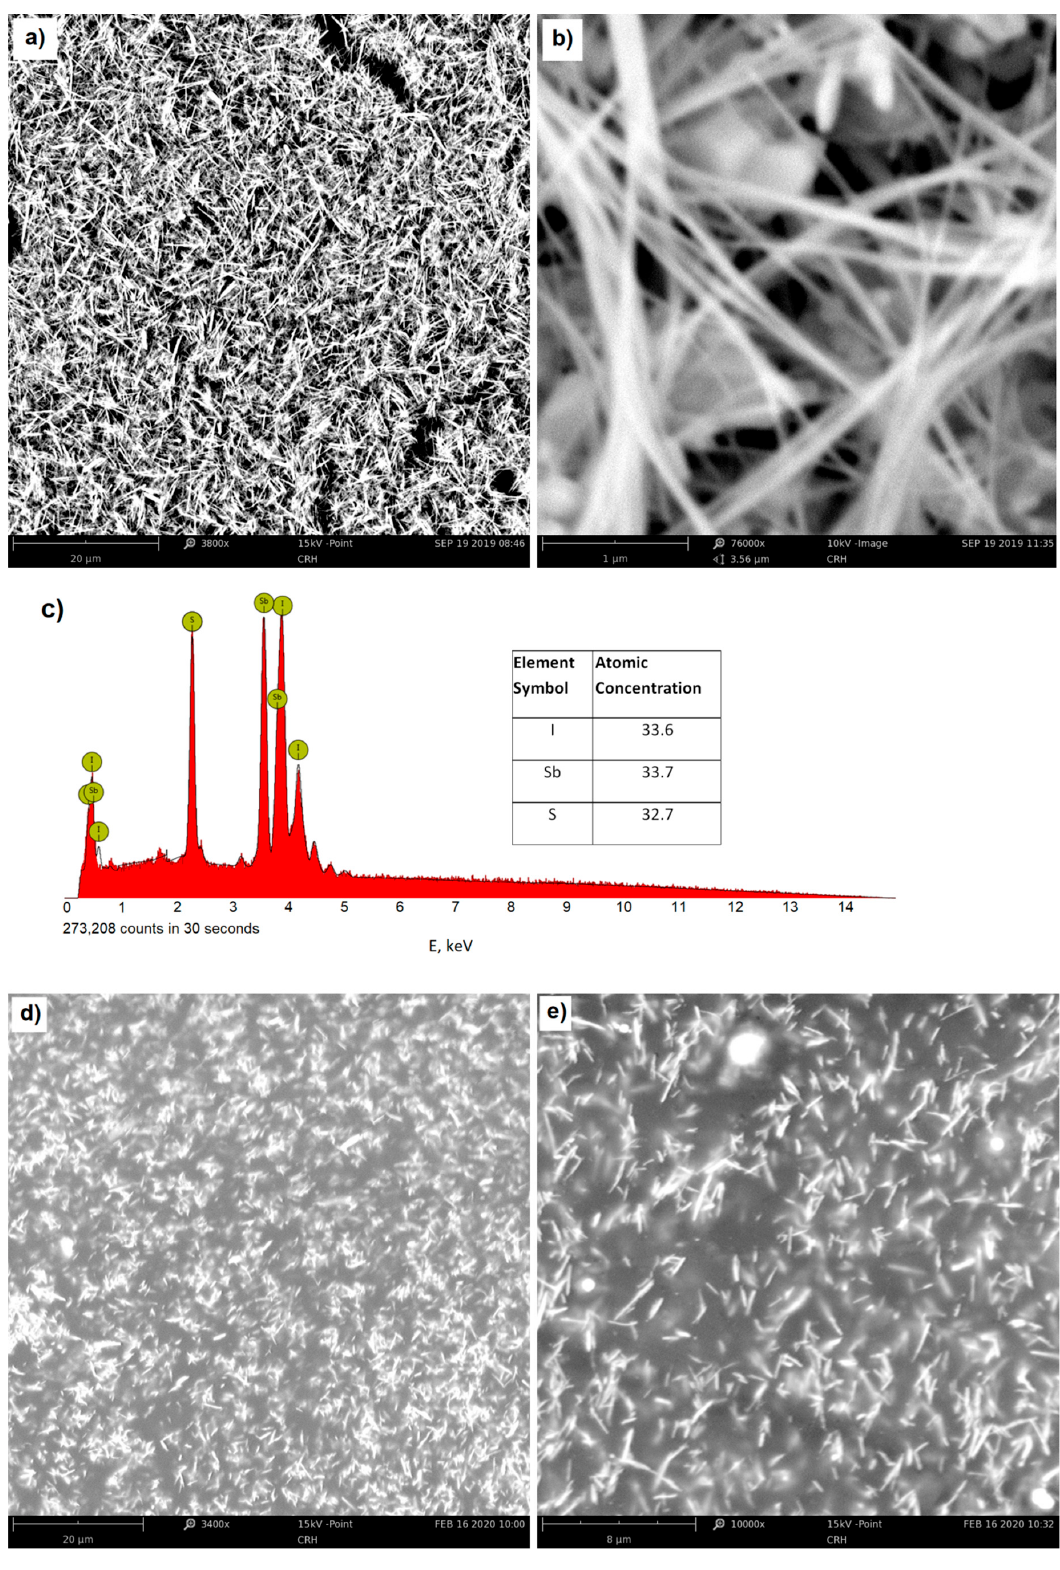
Figure 2. The SEM micrographs ( a , b ) and EDS spectrum ( c ) of SbSI nanowires—the inset table shows the atomic concentrations of elements, ( d , e ) SEM micrographs of the obtained nanocomposite of epoxy resin with SbSI nanowires.